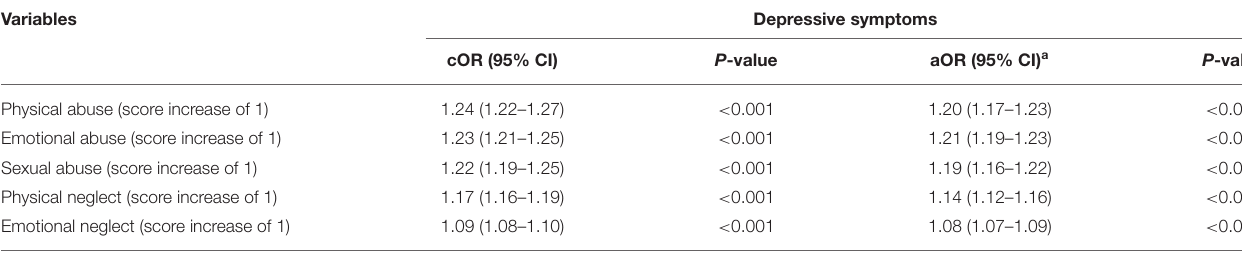
TABLE 2 | Associations between child maltreatment and depressive symptoms.